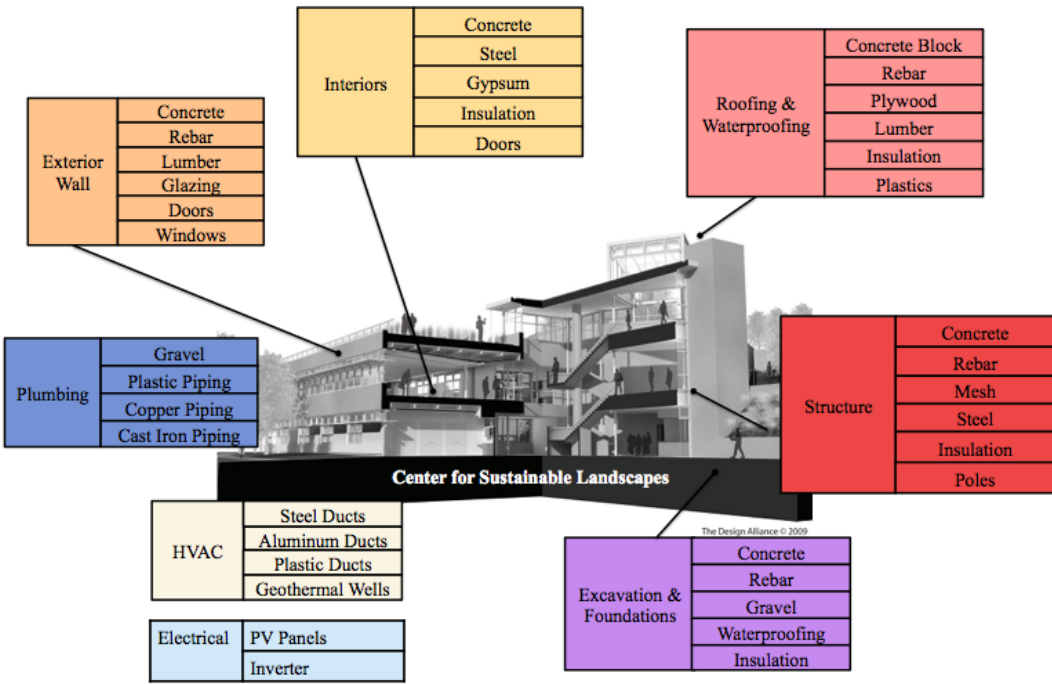
Figure 1. System boundary: material phase for illustrative case study